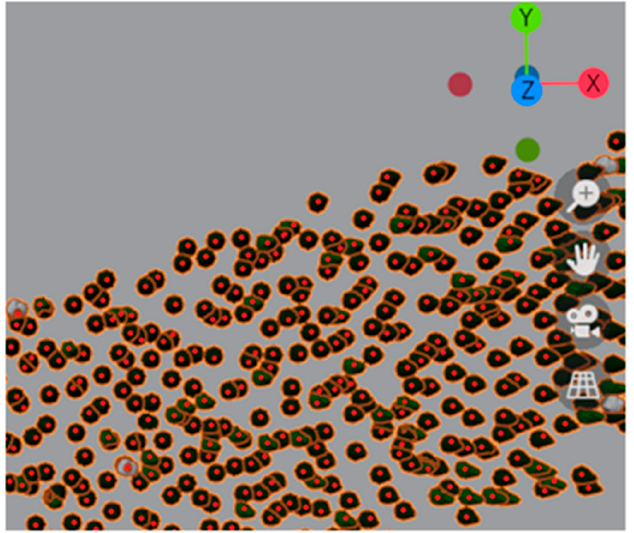
Figure 4. Displaying trees in space.